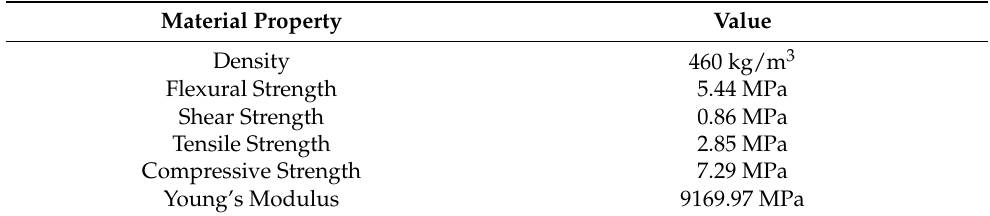
Table 1. Mechanical properties of no. 1/2 spruce pine fir lumber as per the National Design Specification.